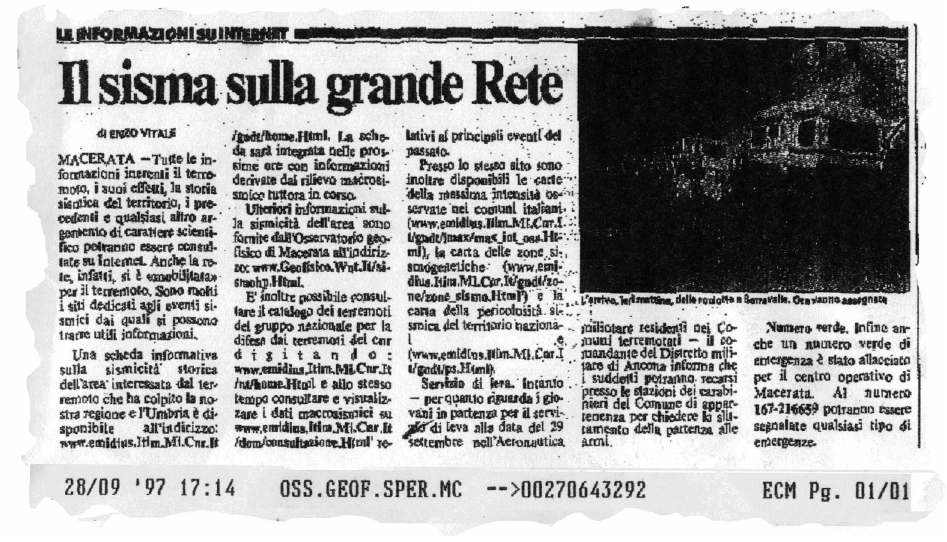
Fig. 2. Article by Enzo Vitale published on Il Messaggero on Sunday, 28, 1997 sent by Osservatorio Geofisi- co di Macerata to the GNDT web staff. Note how it refers largely to GNDT fax message of